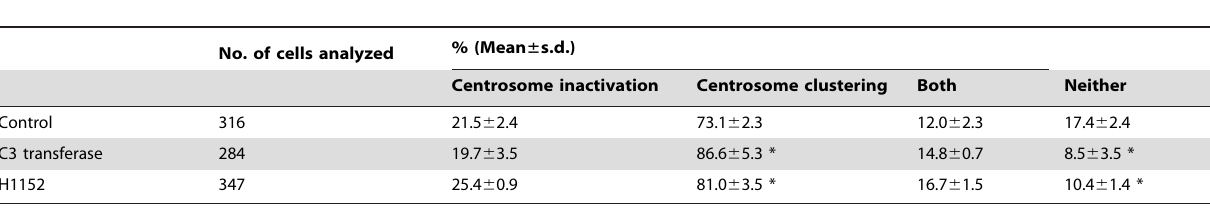
No. of cells analyzed % (Mean ±